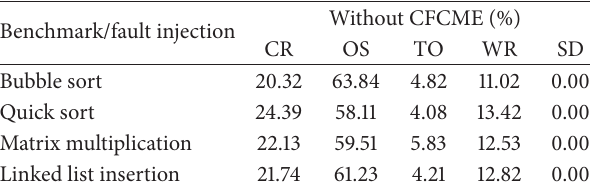
Table 3: Fault injection results on kernel components without CFCME.